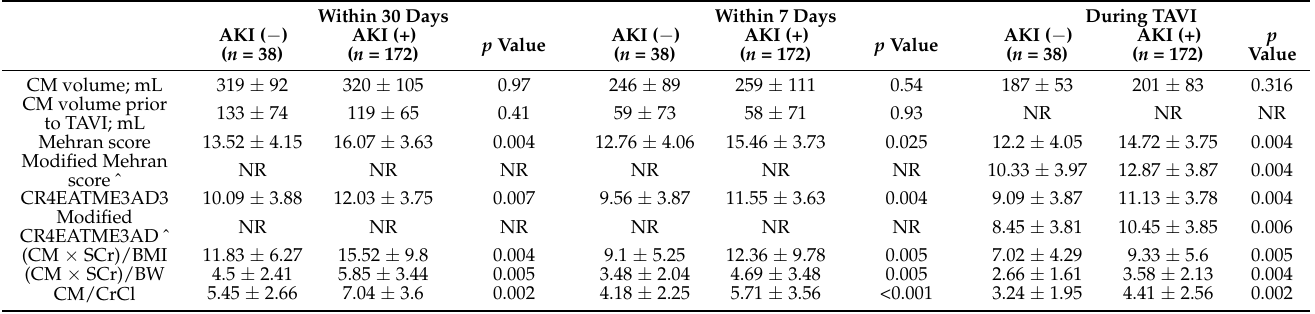
Table 3. Contrast media and risk models